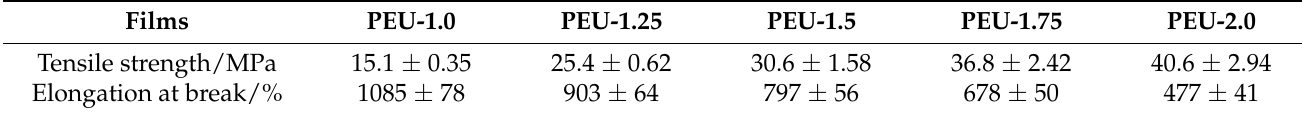
Figure 7. Water absorption of PEU films as function of immersion time ( n = 3).